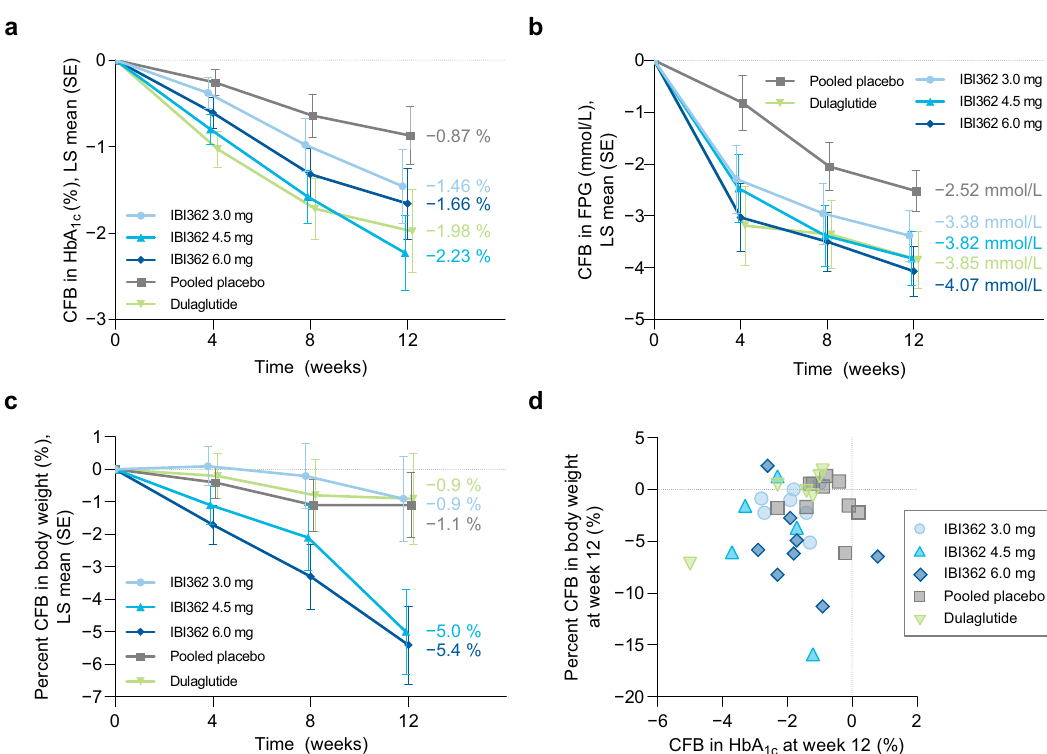
Fig. 2 Change from baseline in HbA 1c , fasting plasma glucose and body weight over time and at week 12. a CFB in HbA 1c levels over time. b CFB in FPG levels over time. c Percent CFB in body weight over time. d CFB in HbA 1c levels and percent CFB in body weight for each patient at week 12. Data in a – c are plotted as LS means± SEM from an MMRM model, with LS means at week 12 shown alongside. IBI362 3.0 mg n = 8; IBI362 4.5 mg n = 8; IBI362 6.0 mg n = 8; Pooled placebo n = 12; Dulaglutide n = 6. CFB, change from baseline, FPG, fasting plasma glucose, HbA 1c , glycated haemoglobin A 1c , LS, least squares, MMRM, mixed-effect model for repeated measures, SE, standard error of the mean. Source data are provided as a Source Data fi